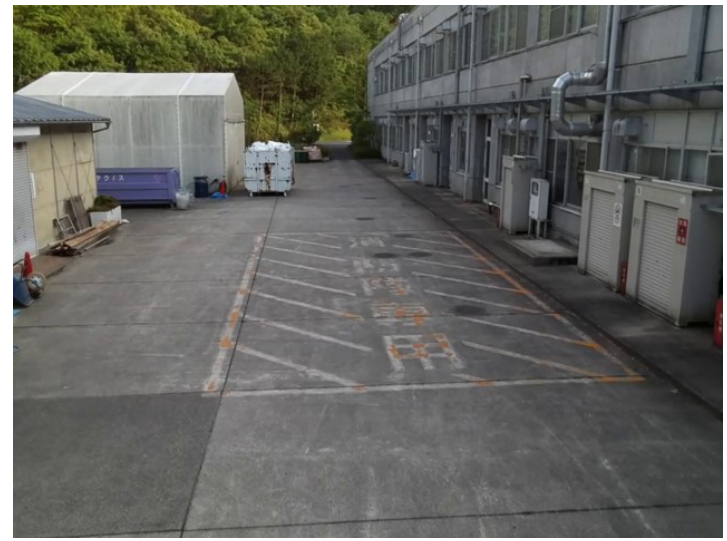
Figure 18. The testing area of interest of a parking